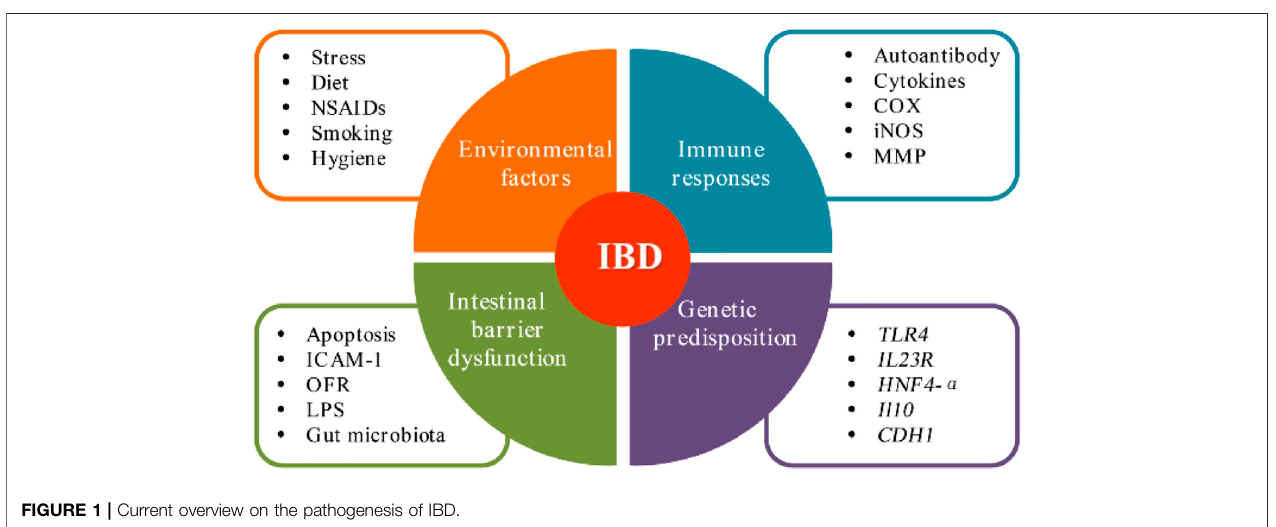
FIGURE 1 | Current overview on the pathogenesis of IBD.